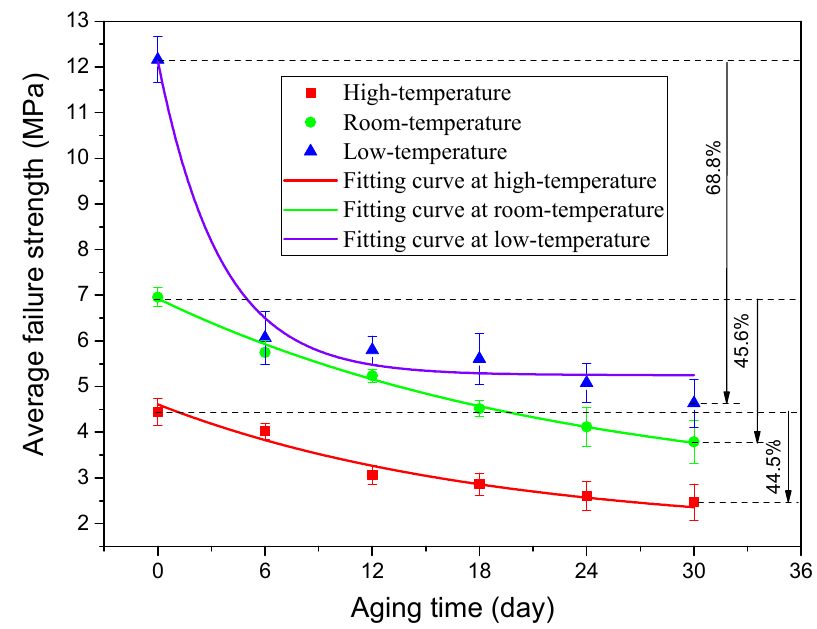
Figure 9. Fitting curves of average failure strength of BJs.